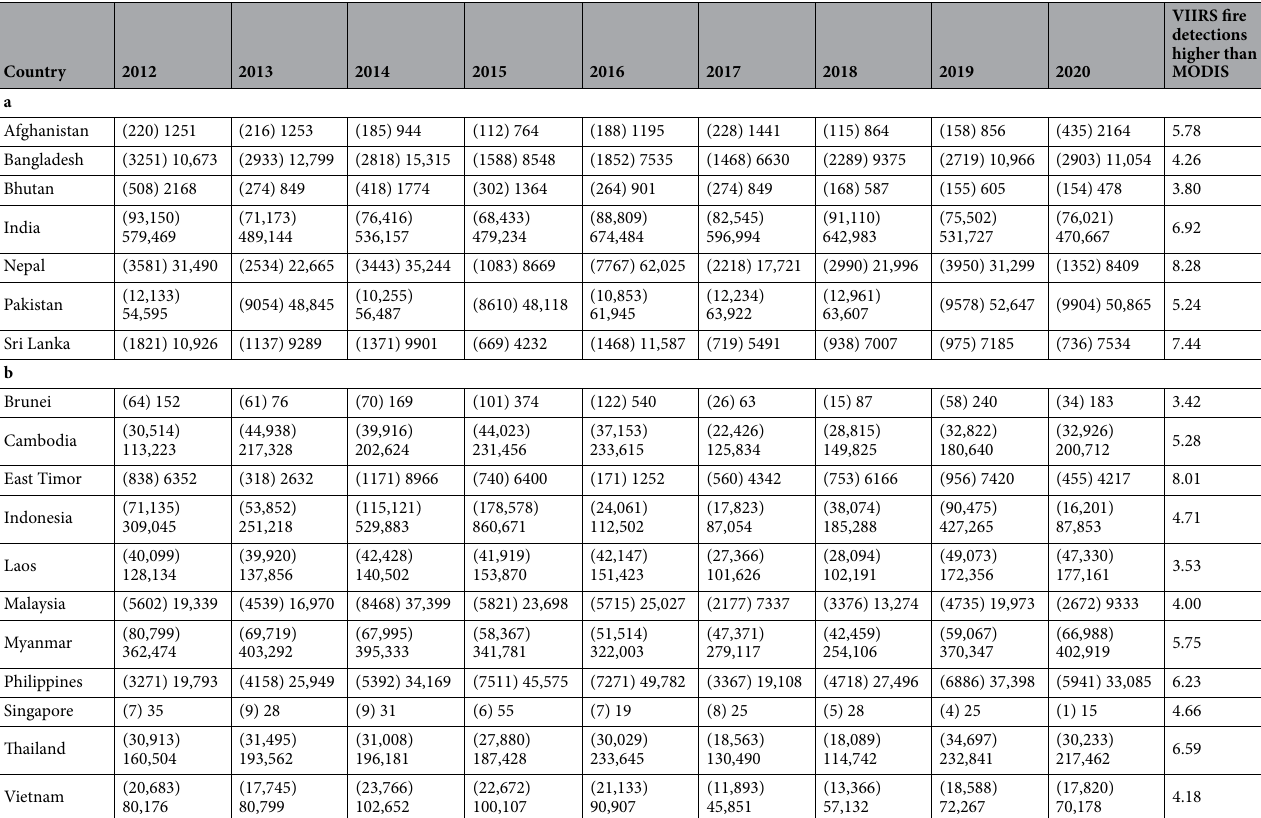
Table 1. a, b. MODIS and VIIRS annual fire detections for different years in South/Southeast Asian countries. MODIS detections shown in parenthesis and VIIRS without. On an average VIIRS could detect 5.28 times more fires in South Asia and 5.12 times more fires in Southeast Asian